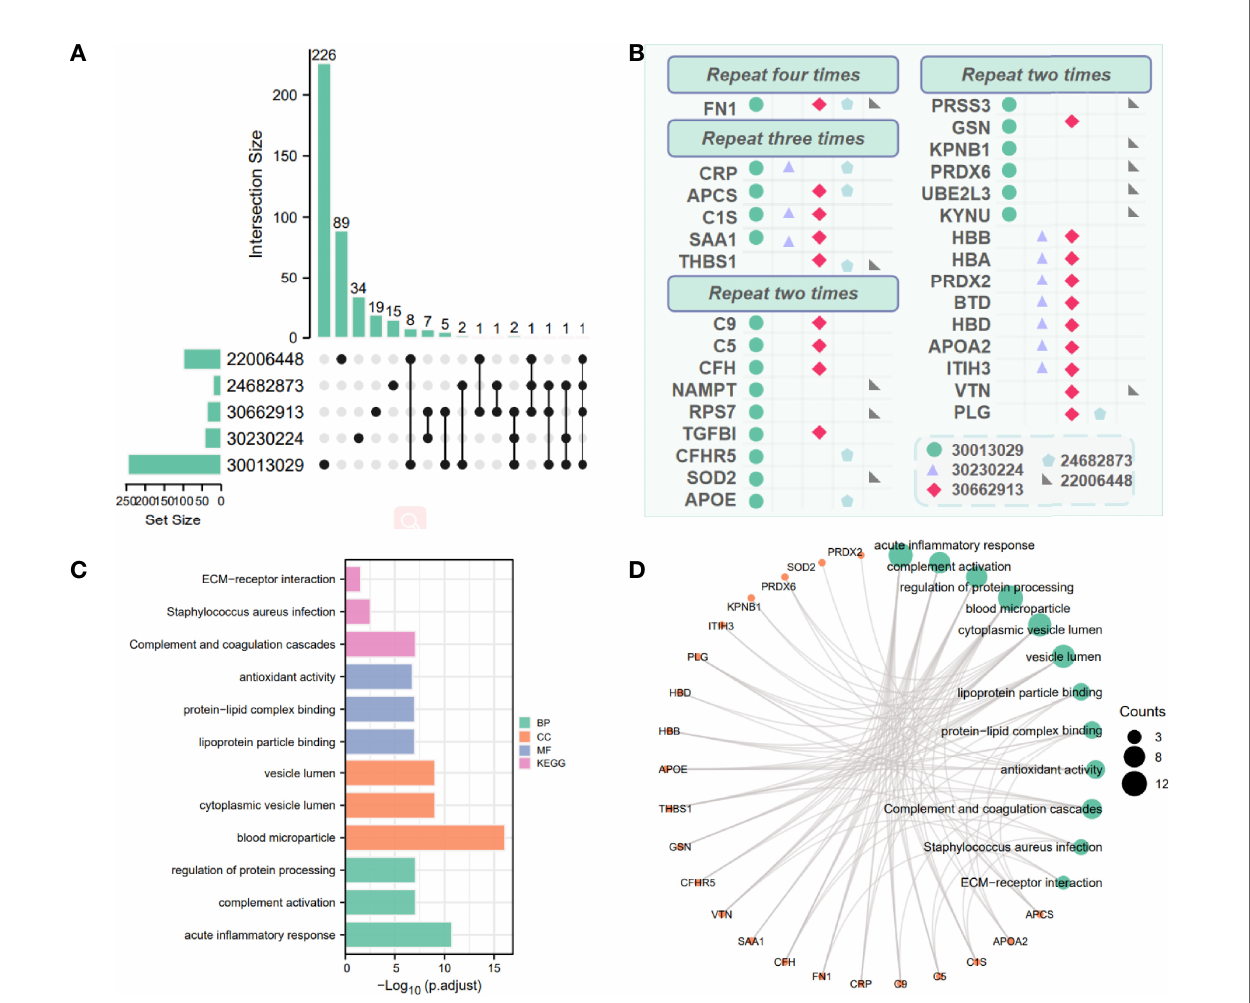
FIGURE 3 | Combine other proteomics datasets to analyze differential proteins. (A) Crossover situation in 5 proteomics datasets. (B) Visually display differential proteins co-expressed (greater than 2) in multiple proteomics datasets. Different shapes and colors represent different datasets. (C, D) Enrichment results of 30 differential proteins in 5 proteomics datasets. The green size represents the number of counts corresponding to the